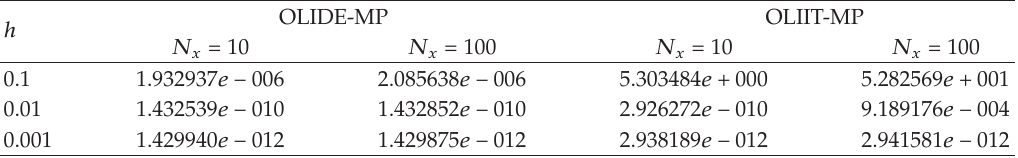
Table 4: The errors (cid:16) at t (cid:5) 10 when the algorithms are applied to the problem (cid:3) 5.6 (cid:4) with the coe ffi cients group III, where τ (cid:3) t (cid:4) (cid:5)